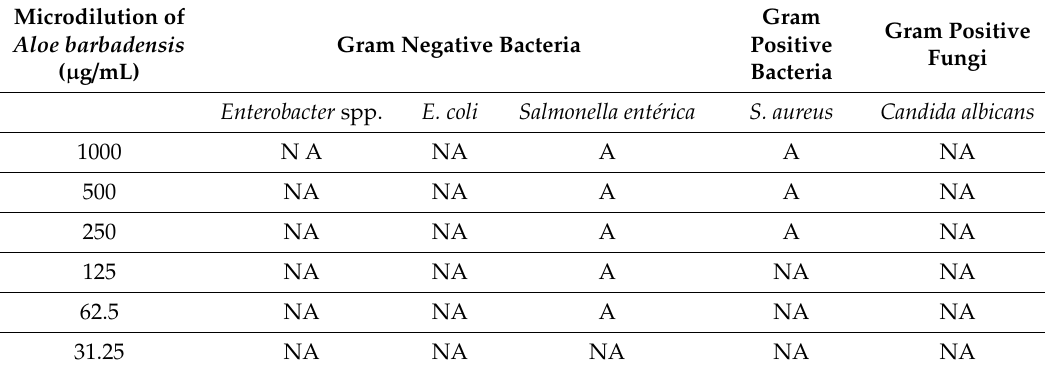
Gram Gram Positive Positive Fungi Bacteria